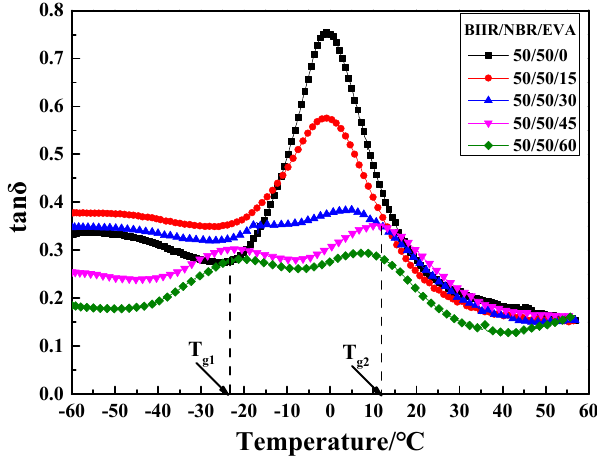
Figure 17 . Damping properties versus temperature of NBR/BIIR/EVA with various blend ratios. Figure 17. Damping properties versus temperature of NBR / BIIR / EVA with various blend